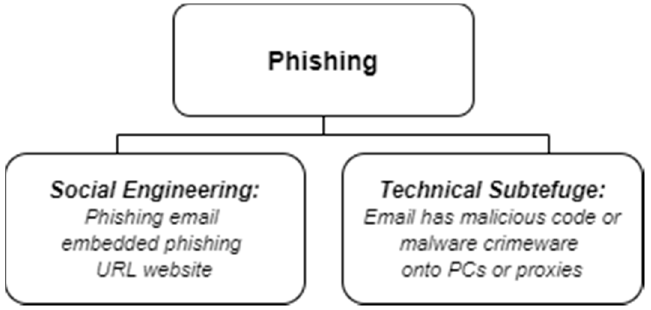
Figure 1. Social engineering attack taxonomy. Reproduced from Figure 2 in [17].